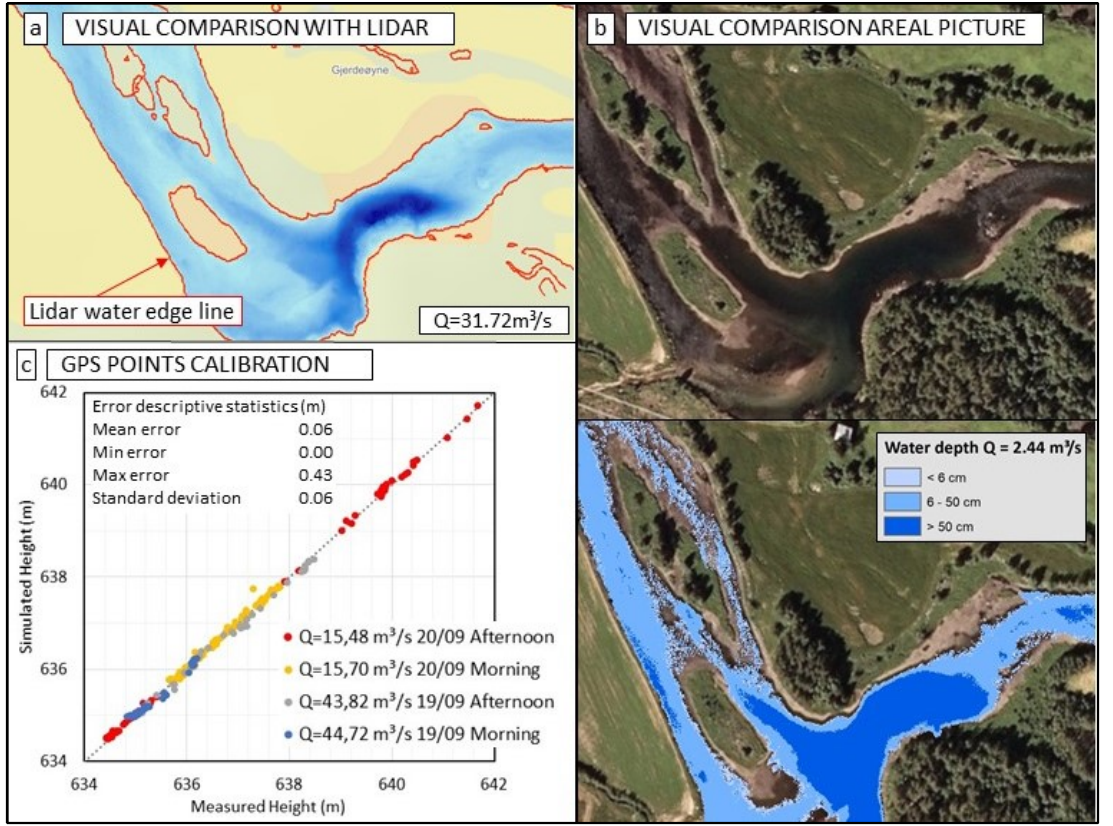
Figure 3. Calibration: ( a ) Comparison with LiDAR water edge recorded the day of the flight (Red) at Q = 31m³/s, ( b ) Comparison with Norge i bilder picture at 2.44 m³/s, ( c ) GPS points calibration.